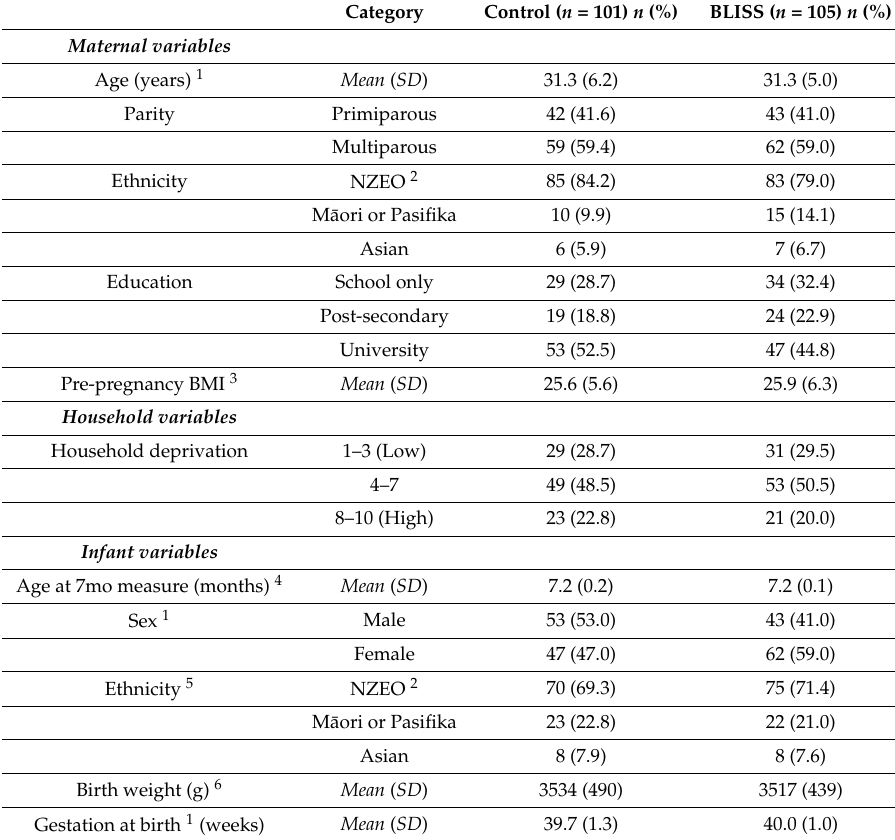
Table 1. Characteristics of the study